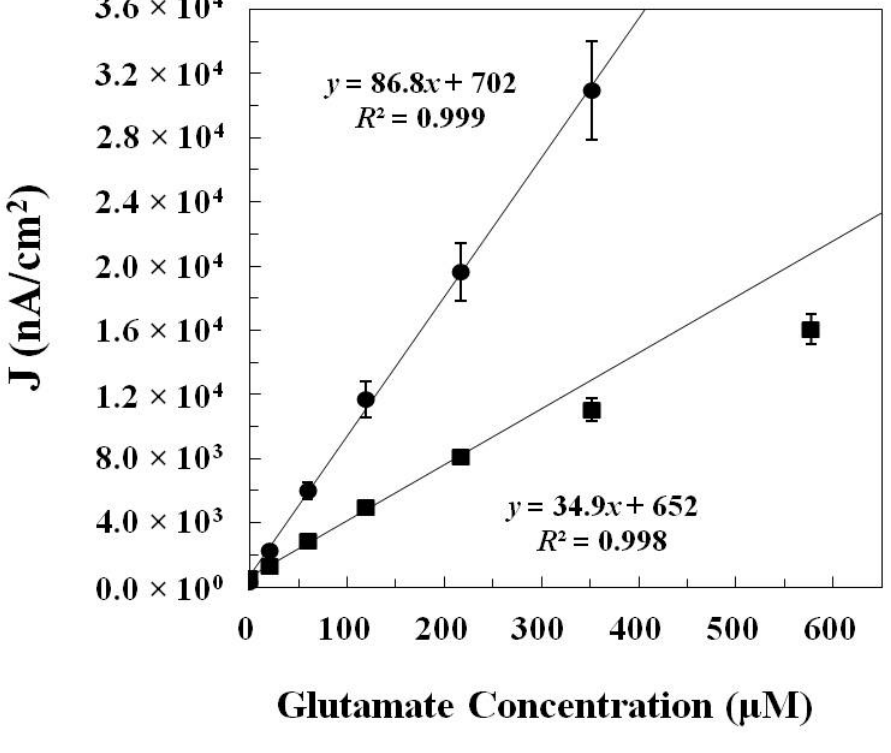
Figure 2. The in vitro calibration data of glutamate sensors prepared by Method 1 ( ■ ) (N = 8) and Method 2 ( ● ) (N = 12). The corresponding glutamate sensing current density ( J in nA/cm 2 ) is plotted vs. glutamate concentration ( μ M).